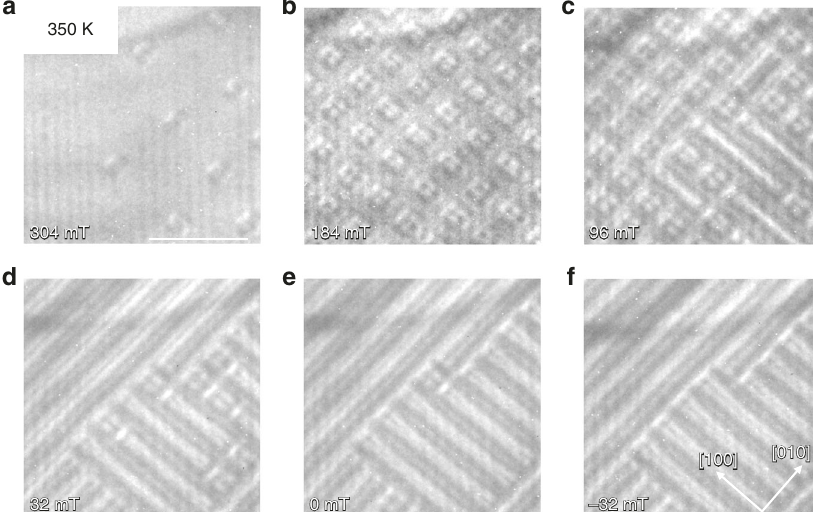
32 mT32 mT 0 mT0 mT Fig. 2 Formation of square antiskyrmions. The fi gure shows the evolution of the LTEM contrast with decreasing fi eld applying the modi fi ed experimental protocol (applying reversible tilting along [1 1 0] at high fi elds until a lattice of objects has formed) at the highest investigated temperature of 350 K. We observe the transition from the fi eld-polarized state, to a few isolated objects in a , to a lattice of square antiskyrmionic features in b , c , to the helical phase in d – f . The scale bar corresponds to 500 [1 0 0] and a short axis that is directed along [0 1 0]. These objects center. The objects exist at zero fi eld (Fig. 3e) and are partially in the LTEM images are surrounded by a black line with a white metastable even for fi elds as large as − 48 mT, where a transition to contrast in the center at higher fi elds. Upon decreasing the fi eld, a helical phase sets in (Fig. 3f). These objects would appear to look these objects become larger and a gray contrast appears in their like Bloch-like skyrmions, as previously observed 2,3,6 , but these